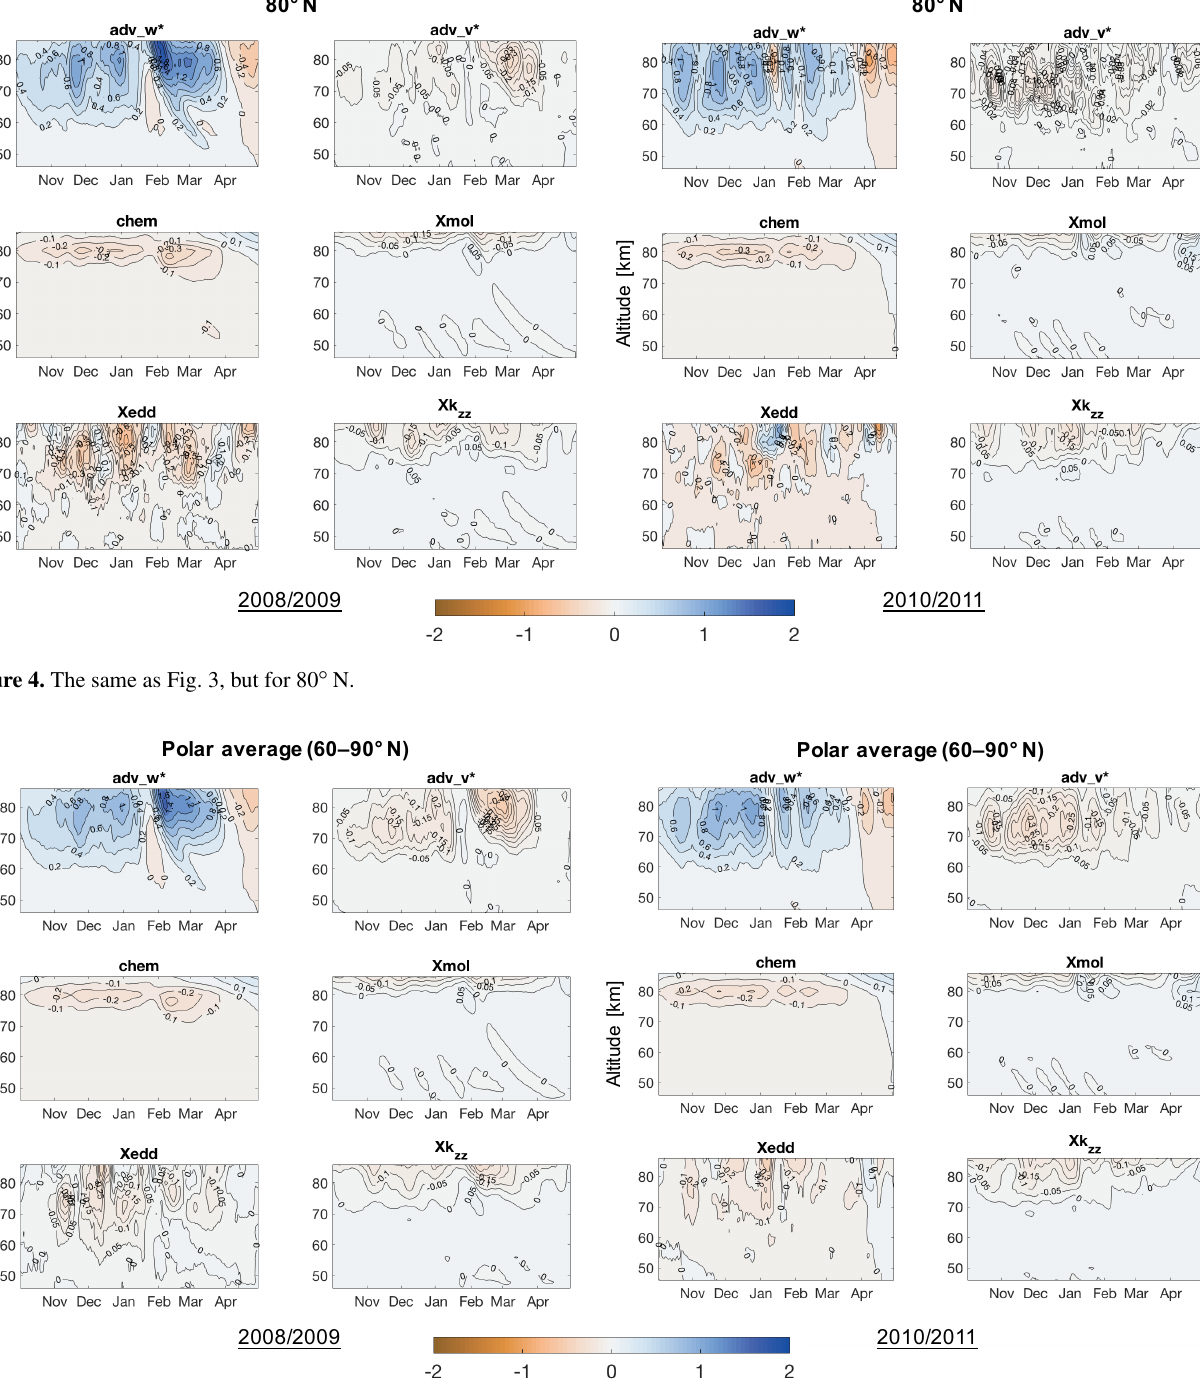
Figure 5. The same as Fig. 3, but for the north polar average (60–90 ◦ N).